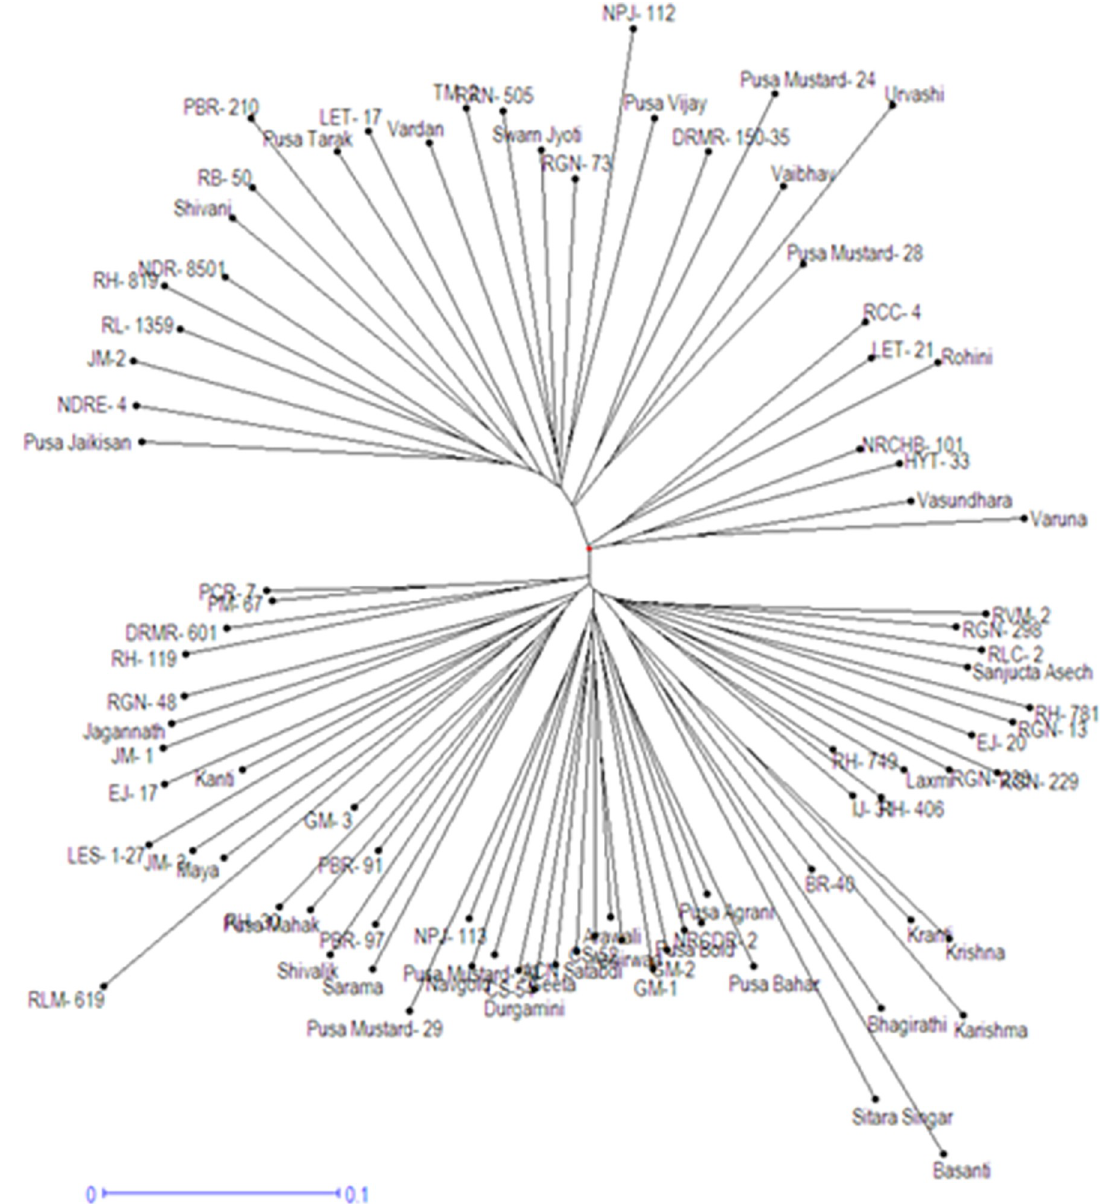
Fig 1. UNJ-dendrogram showing genetic relationship among 87 Indian mustard varieties using 174 SSR markers.